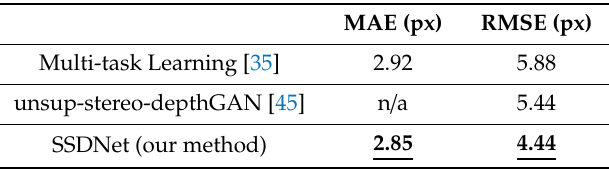
Table 6. Depth completion results on CityScapes